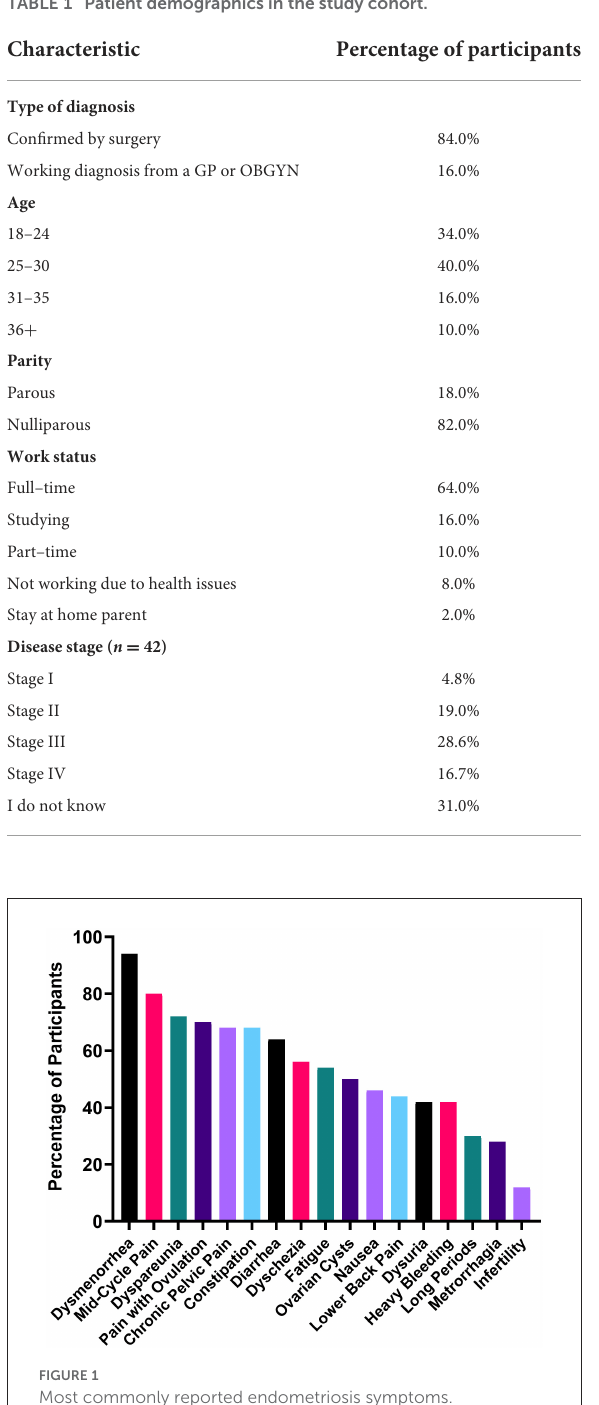
blacking out from pain (2%). While these symptoms were less common, they are indicative of the wide variety of debilitating experiences of endometriosis patients. In this cohort, 8% of patients were not working as a result of their